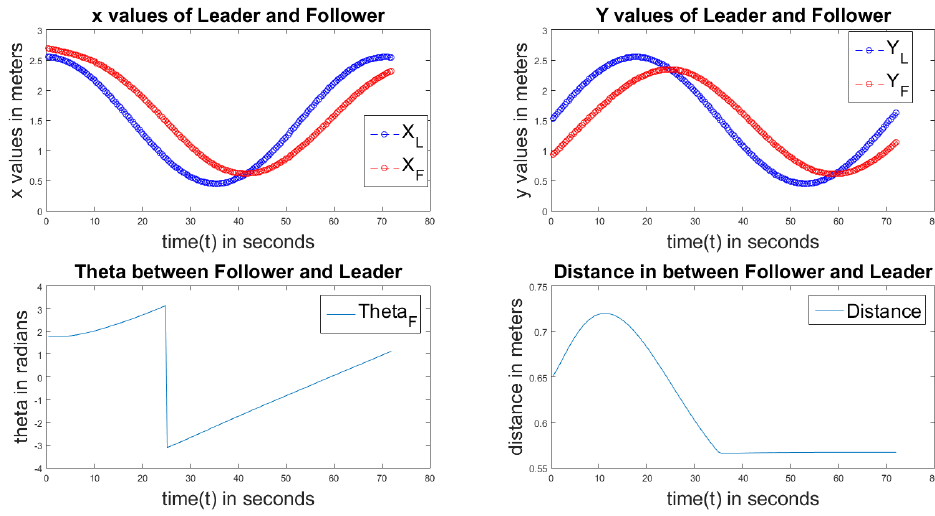
Figure 7. P controller of a circle.